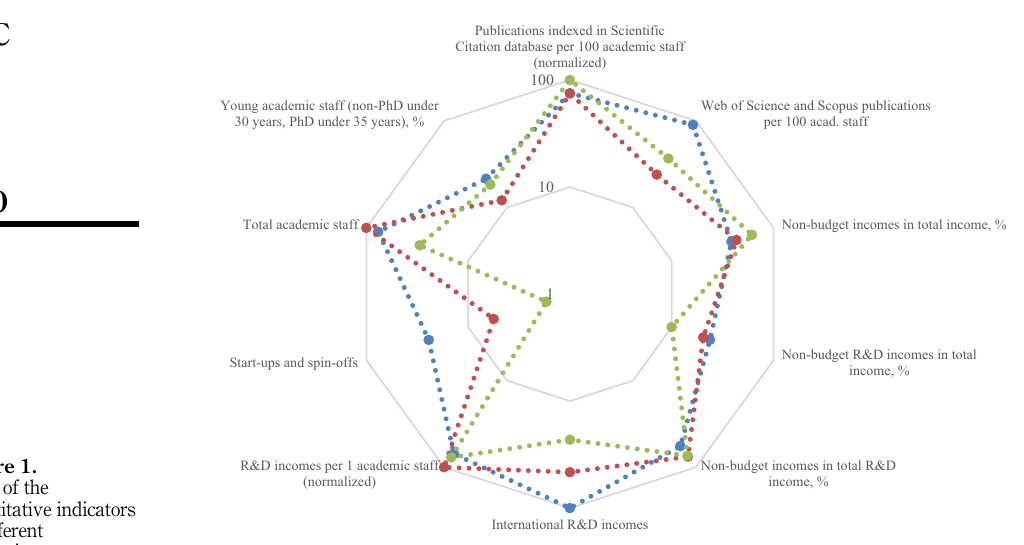
Figure 1. Some of the quantitative indicators of